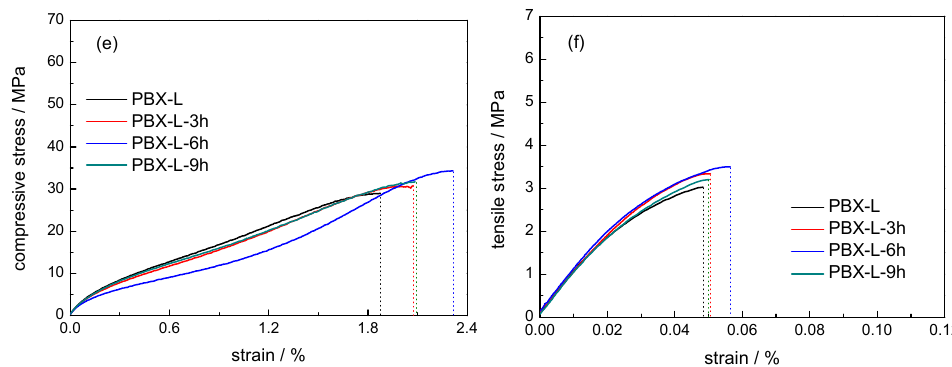
Figure 4. The typical mechanical response at room temperature for PDA modified PBXs: compressive test ( a , c , e ); Brazilian test ( b , d , f ).